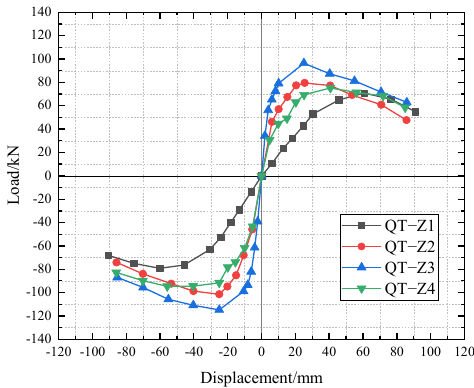
Figure 18. Skeleton curves.